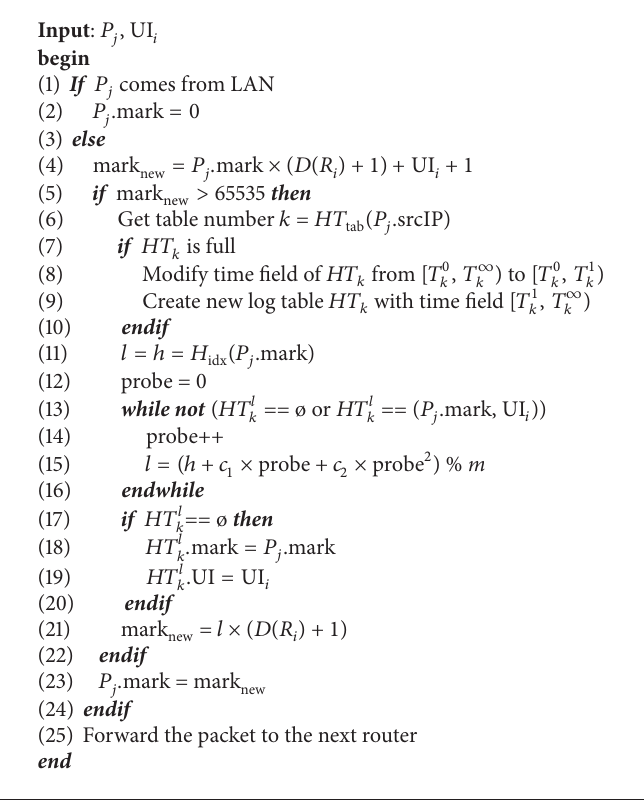
Algorithm 1: Marking and logging scheme.